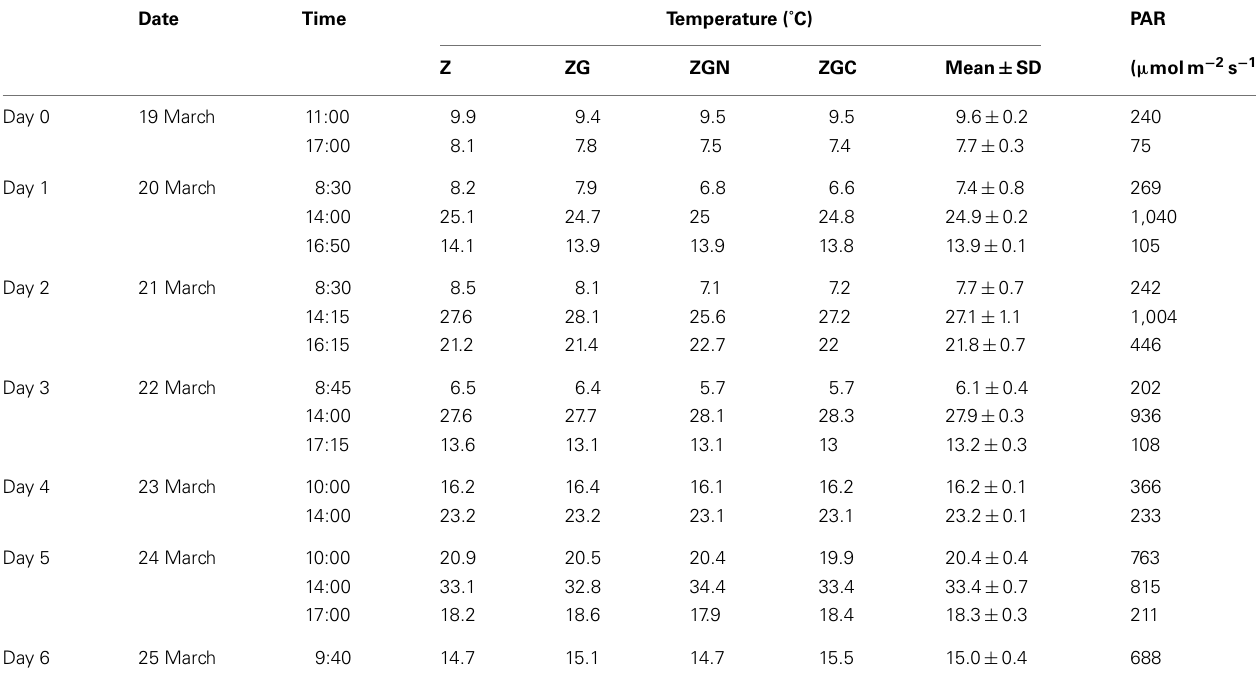
Temperature was measured in each treatment (see Table 1 for growth media abbreviation explanations) and mean ± SD were calculated. Photosynthetically active